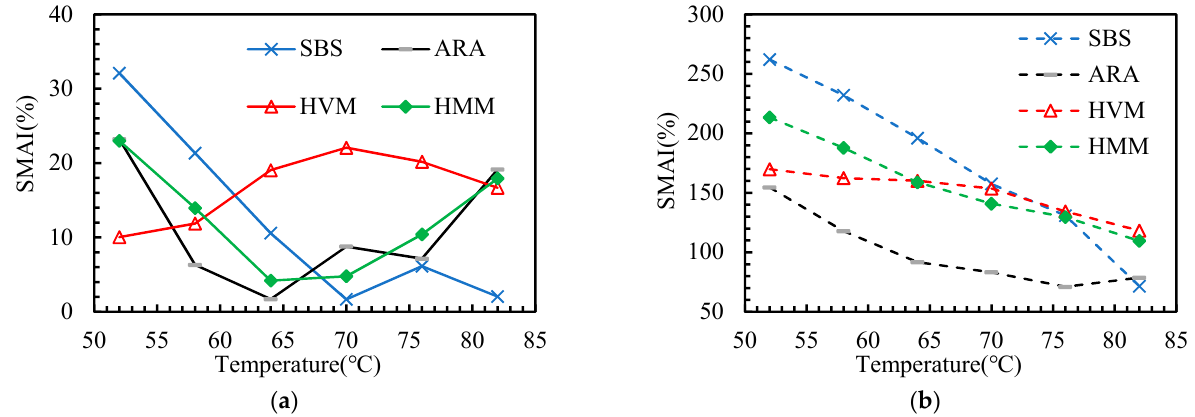
Figure 9. Storage Modulus Aging Indicator (SMAI) of the asphalt binders after aging: ( a ) TFOT; ( b ) PAV.